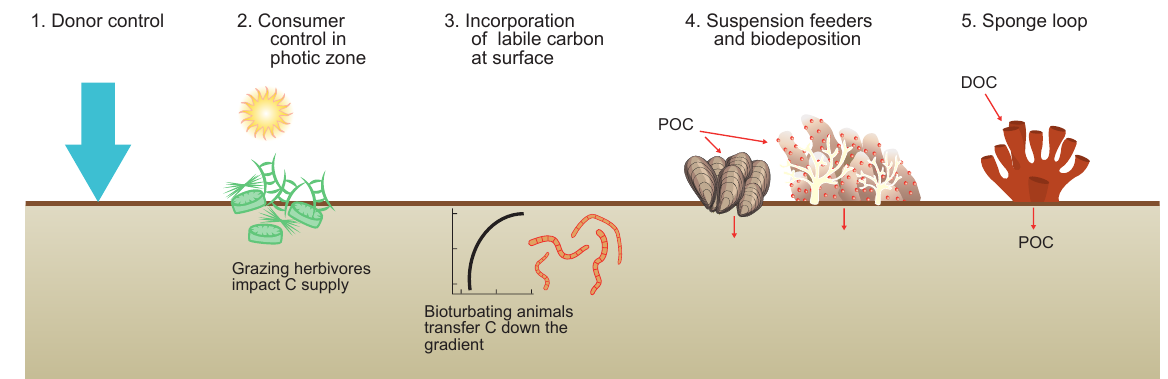
Figure 5. Organic matter supply to sediments. (1) The traditional view of organic matter settling passively from the water column (donor control). (2) Sediments in the photic zone are inhabited by benthic microalgae that produce new organic matter in situ and grazing animals can impact the growth of these primary producers. (3) Bioturbating animals transfer labile carbon from the sediment surface layer to deeper layers in the sediments. (Vertical axis is depth; horizontal axis is concentration.) (4) Suspension-feeding organisms enhance the transfer of suspended particulate matter from the water column to the sediments (biodeposition). (5) Sponge consume dissolved organic carbon and produce cellular debris that can be consumed by benthic organisms (i.e., the sponge